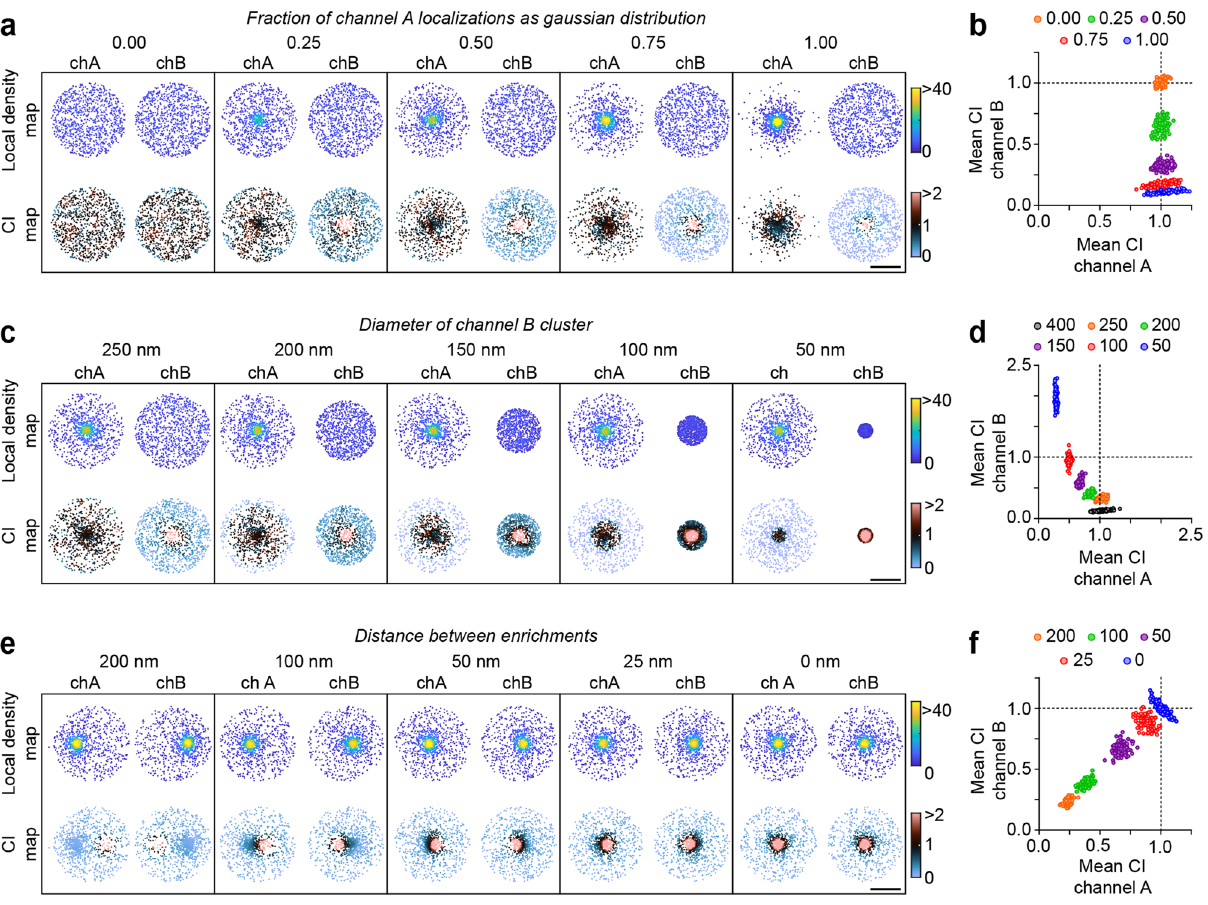
Figure 2. Detection of spatial association within highly confined regions. ( a ) Examples of simulated clusters in which points in channel A are increasingly concentrated towards the center of the cluster whereas channel B remains homogenous in each condition. ( c ) Examples of simulated point patterns with the cluster in channel B varying in size. ( e ) Examples of simulated point patterns in which both channels have a local enrichment with varying distances between the two enrichments. For each of the tests in ( a , c , e ) a map is shown color-coded for the local density (top) or the co-localization index (CI; bottom). For all clusters, the effective resolution used as search radius was ~ 16 nm. ( b , d , f ) Graphs showing mean co-localization index for 100 simulated point patterns per condition for the experiments show in ( a , c , e ) respectively. Scale bar for ( a , c , e ), 100 nm. CI co-localization index, Ch